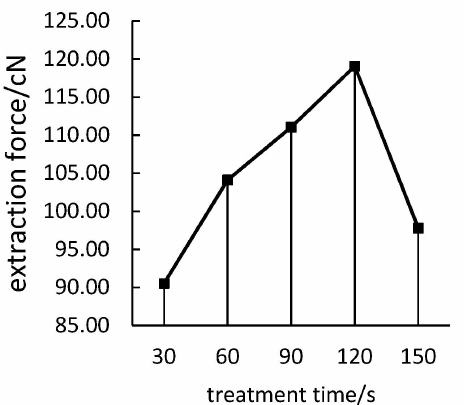
Figure 4. Effect of treatment time on the extraction force.